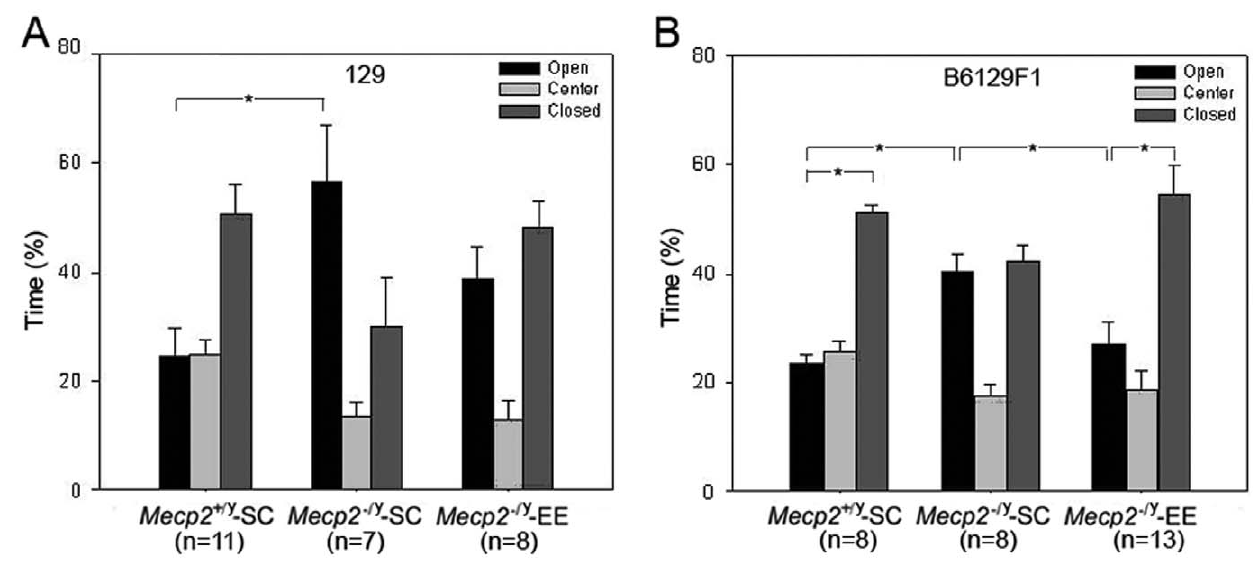
Figure 3. Environmental Enrichment restores a normal behavior in the plus maze test. A, In the elevated plus maze, significant increases in the percentage of time spent in open arms were seen in Mecp2 2 /y -SC (129 genetic background) compared with Mecp2 + /y -SC mice. This phenotype is reversed in the Mecp2 2 /y -EE mice. B, In a B6129 F1 genetic background, Mecp2 2 /y -EE mice showed a behavior indistinguishable from the Mecp2 + /y - SC mice. Mean 6 SEM are presented. Two way ANOVA (genotype 6 condition) demonstrated differences in the mean values among the different levels of Genotype (F=10.705; p=0.003) and condition (F=7.516; p=0.011). Post hoc Student’s t test detected statistical differences between groups, *: p ,